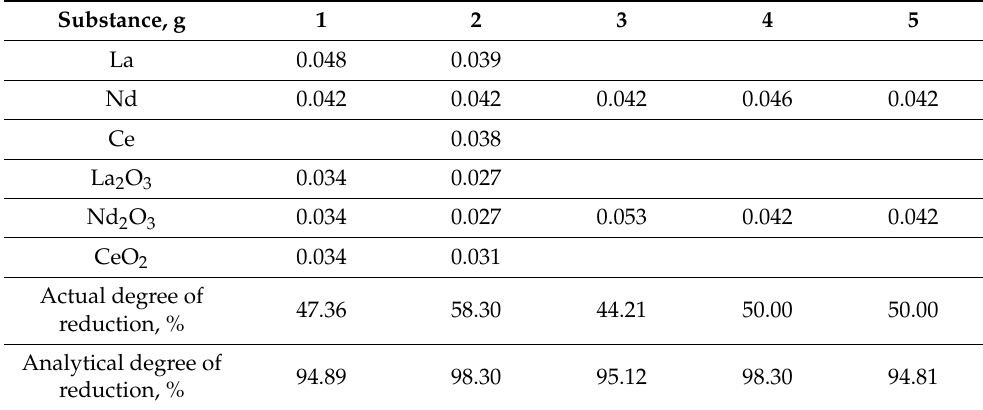
Table 5. Concentrations of oxide and metallic REM phases determined using the bromine method in model